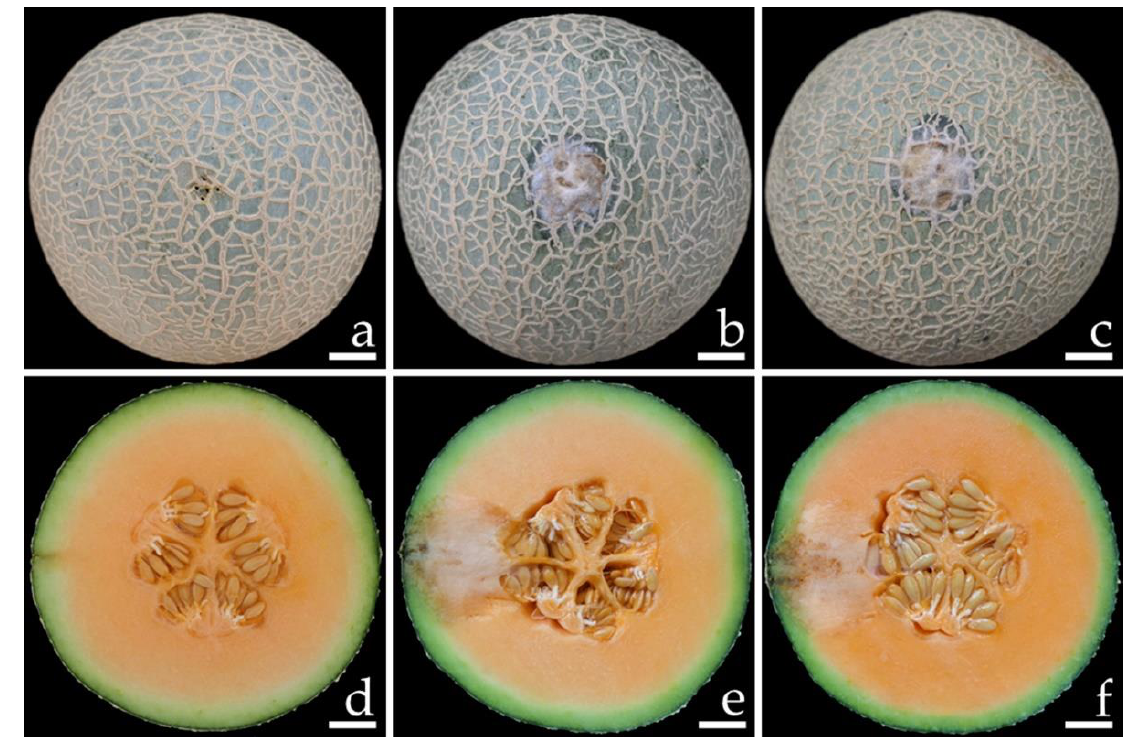
Figure 6. Pathogenicity test using F. melonis SDBR-CMU424 and SDBR-CMU425 on melon ( Cucumis melo ) fruits after one week of inoculation. Control fruit treated with water instead of inoculum ( a , d ). Fruit rot after inoculation of isolate SDBR-CMU424 ( b , e ) and isolate SDBR-CMU425 ( c , f ). Scale bars = 20 mm.